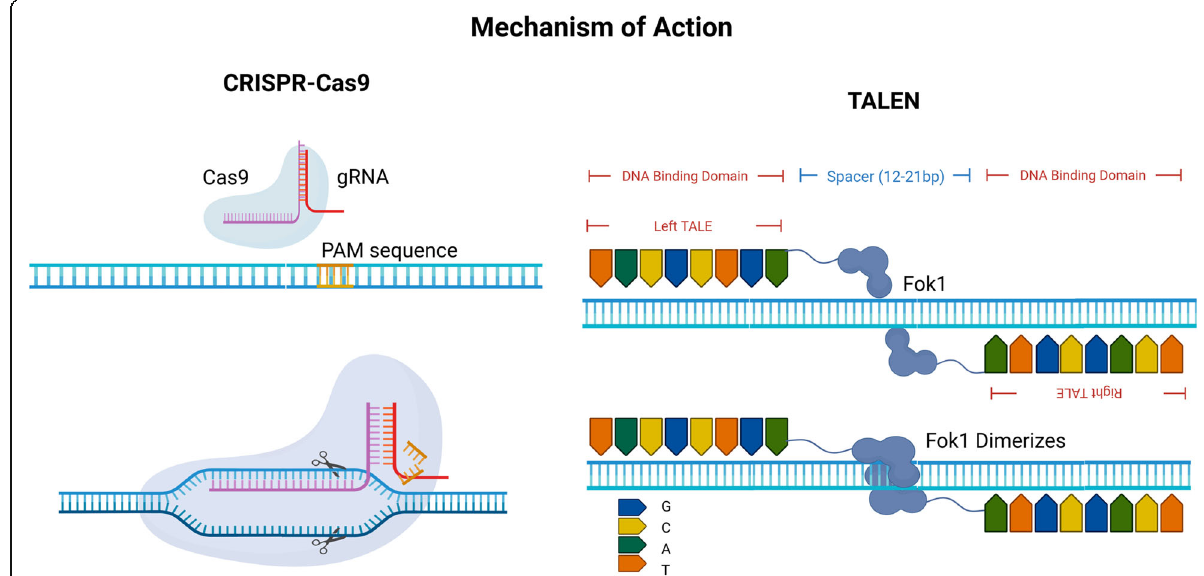
Fig. 2 Schematic illustration of mode of action of genome editing nuclease (TALENs and CRISPRs) inducing a double-strand break on the target DNA